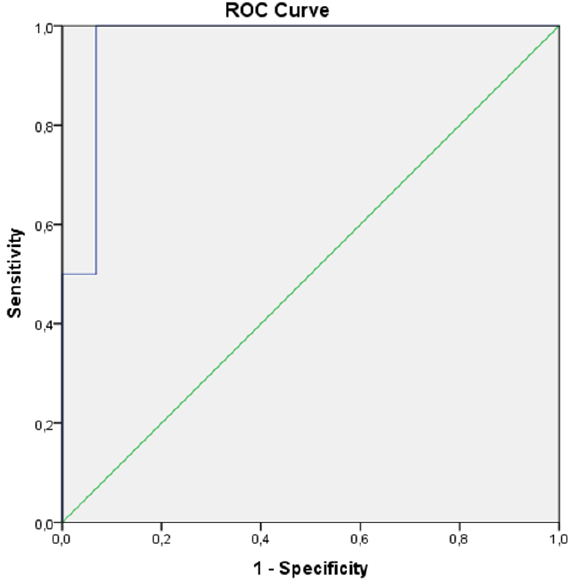
Figure 2. ROC curve in 2018 comparing the Jones and Beneish models. Source: own research.